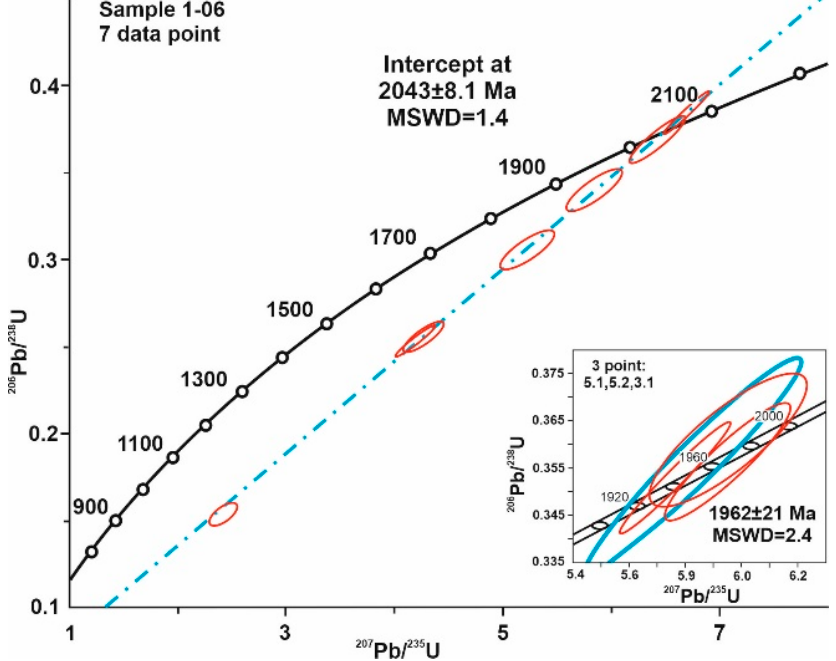
Figure 32. Concordia diagram for zircons from the granite gneisses (sample 1-06) collected from an outcrop in the Nemtikha Group.